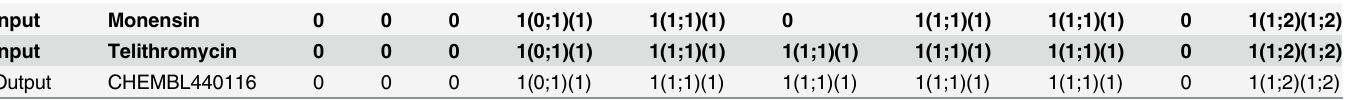
Table 2. Matching quantum scores of input and output molecules from monesin and telithromycin.